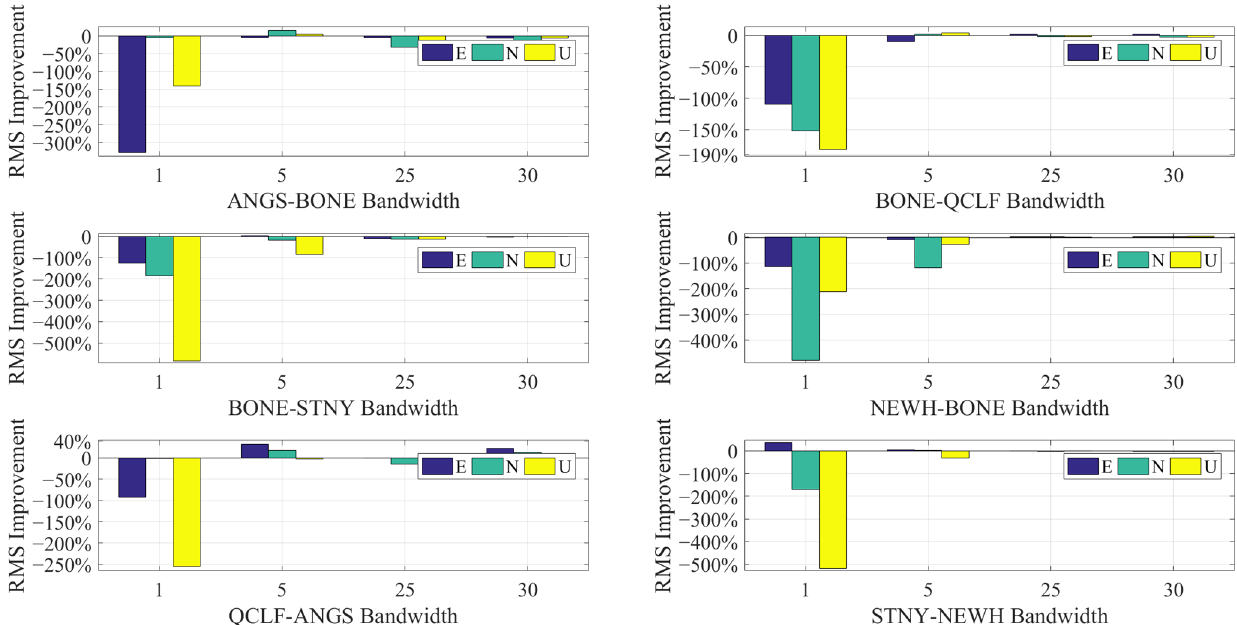
Figure 8. RMS improvement on each baseline.